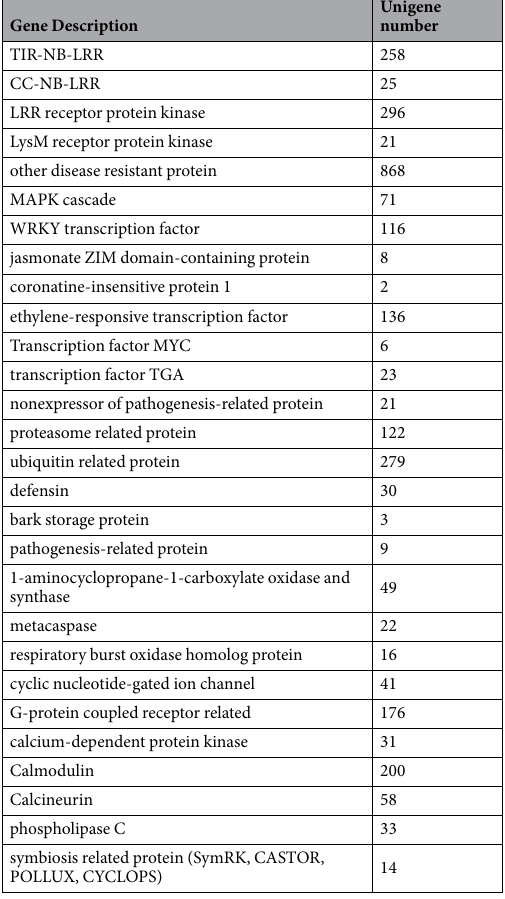
up-regulation in AF compared to AM, while the genes in subcluster 4 showed significantly higher up-regulation in AM compared to AF. In particular, the genes in subcluster 1 were up-regulated in AM but down-regulated in AF (Fig. 3). The functional characteristics of the DEGs up-regulated by M . anisopliae induction were related to following three aspects, (i) oxidation-reduction process (Feruloyl CoA ortho-hydroxylase 1, Inducible nitrate reductase [NADH] 2, Probable nucleoredoxin 1), (ii) transport process (MATE efflux family protein FRD3, lipid transfer protein-like protein, WAT1-related protein At1g70260, high affinity nitrate transporter 2.4, protein NRT1/PTR FAMILY 6.3) and (iii) metabolic process (Siroheme synthase, vacuolar processing enzyme). On the other hand, the genes drastically up-regulated by F . axysporumin induction in subcluster 2 were related to following five aspects, (i) defense (class I chitinase, pro-hevein, defensin D2, lectin, peroxidase, primary amine oxidase, sieve element occlusion a, actin-3), (ii) oxidation-reduction process (1-aminocyclopropane-1-carboxylate oxidase), (iii) transport process (lipid transfer protein), (iv) metabolic process (glucan endo-1,3-beta -glucosidase-like, galactinol-sucrose galactosyltransferase 1-like, phosphoglycerate dehydrogenase, probable polygalacturonase At3g15720, asparagine synthetase), and (v) proteolysis (eukaryotic aspartyl protease family protein, aspar- tic proteinase, Ulp1 protease family carboxy-terminal domain protein) (Supplementary Table 4). It is signifi- cant that only nine DEGs were up-regulated in the M . anisopliae treatment but exhibited down-regulation in the F . axysporum treatment. This portion of the gene is highly likely to be associated with a symbiotic rela- tionship between M . anisopliae and A . hypogaea . Five genes were annotated as, 3 ′ -N-debenzoyl-2 ′ -deoxytaxol N-benzoyltransferase, MATE efflux family protein FRD3, Non-specific lipid-transfer protein 1 and two Feruloyl CoA ortho-hydroxylase 1 (Supplementary Table 4). The remaining four genes were unannotated in the current database. Further, the functional distribution of the up- and down-regulated DEGs were compared in differ- ent treatments. Based on GO annotation, only 16 genes in total DEGs were significantly enriched on the two GO stems (Corrected p-value < 0.05) (Table 4). They were all appeared in the M . anisopliae treatment, with nucleic acid binding transcription factor (GO:0001071) and sequence-specific DNA binding transcription factor (GO:0003700) activity. The directed acyclic graph by topGO showed that sequence-specific DNA bind- ing transcription factor activity (GO:0003700) was subject to nucleic acid binding transcription factor activity (GO:0001071), and then both were classified into the main stem of molecular function (GO:0003674). The 16 DEGs of peanut response to M . anisopliae included a variety of transcription factor, such as WRKY, MYC, TGA,